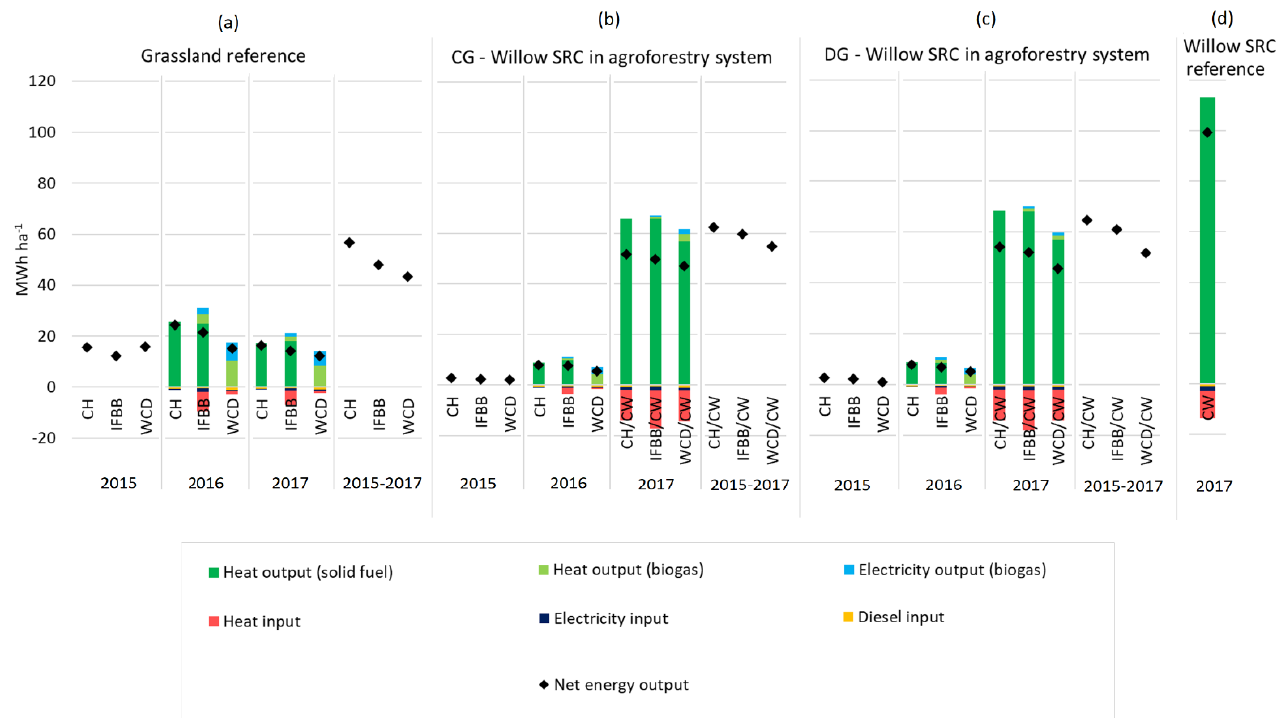
Figure 3. Energy input, output, and net energy yields of ( b ) clover grass (CG) and willow short rotation coppice (SRC) in agroforestry system and ( c ) diverse grassland mixture (DG) and willow short rotation coppice (SRC) in agroforestry system compared to grassland reference stand ( a ) and willow short rotation coppice (SRC) reference stand ( d ) in the second rotation after establishment. Four conversion technologies were applied: combustion of hay (CH), integrated generation of solid fuels and biogas from biomass (IFBB), whole crop digestion (WCD) and combustion of willow woodchips (CW).